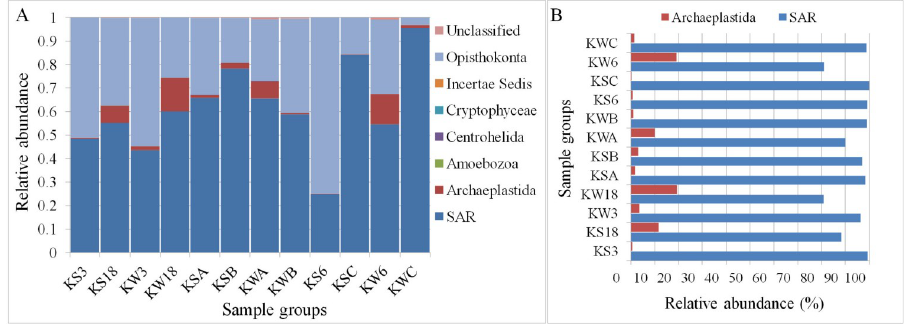
Fig 3. The relative abundance of all eukaryotic groups (A) and algal groups (B) at different stations in Kuwait